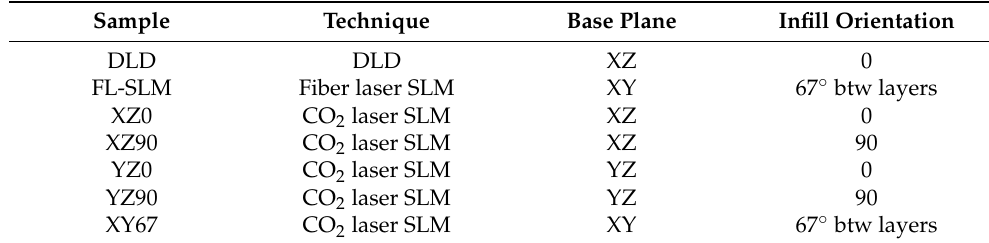
Table 2. Parameters and conditions used in the additive manufacturing processes.